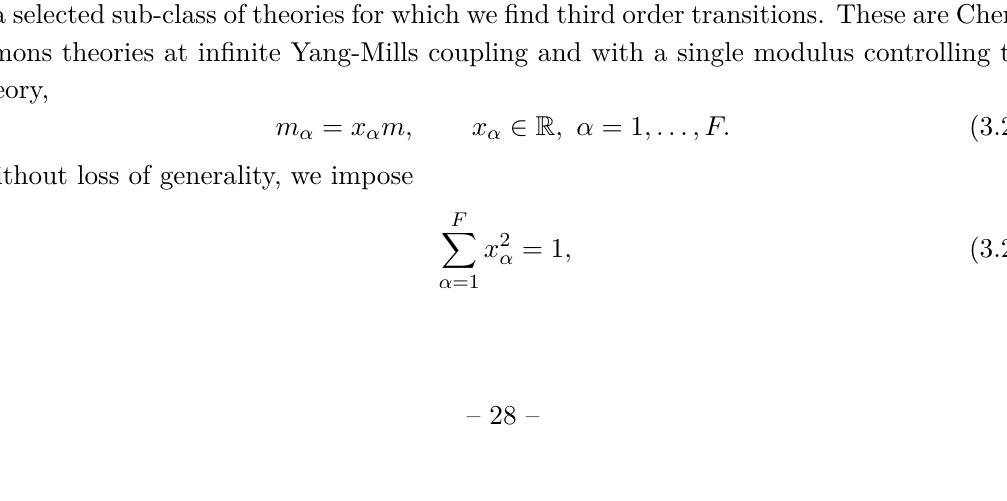
Figure 13 . Phase diagram of the theory with two mass scales. Note that the solid blue walls, representing the critical surfaces, are not straight lines in the ( m may be visualized comparing the upper strip of figure 13 with the phase diagram of the F = 1 theory in figure